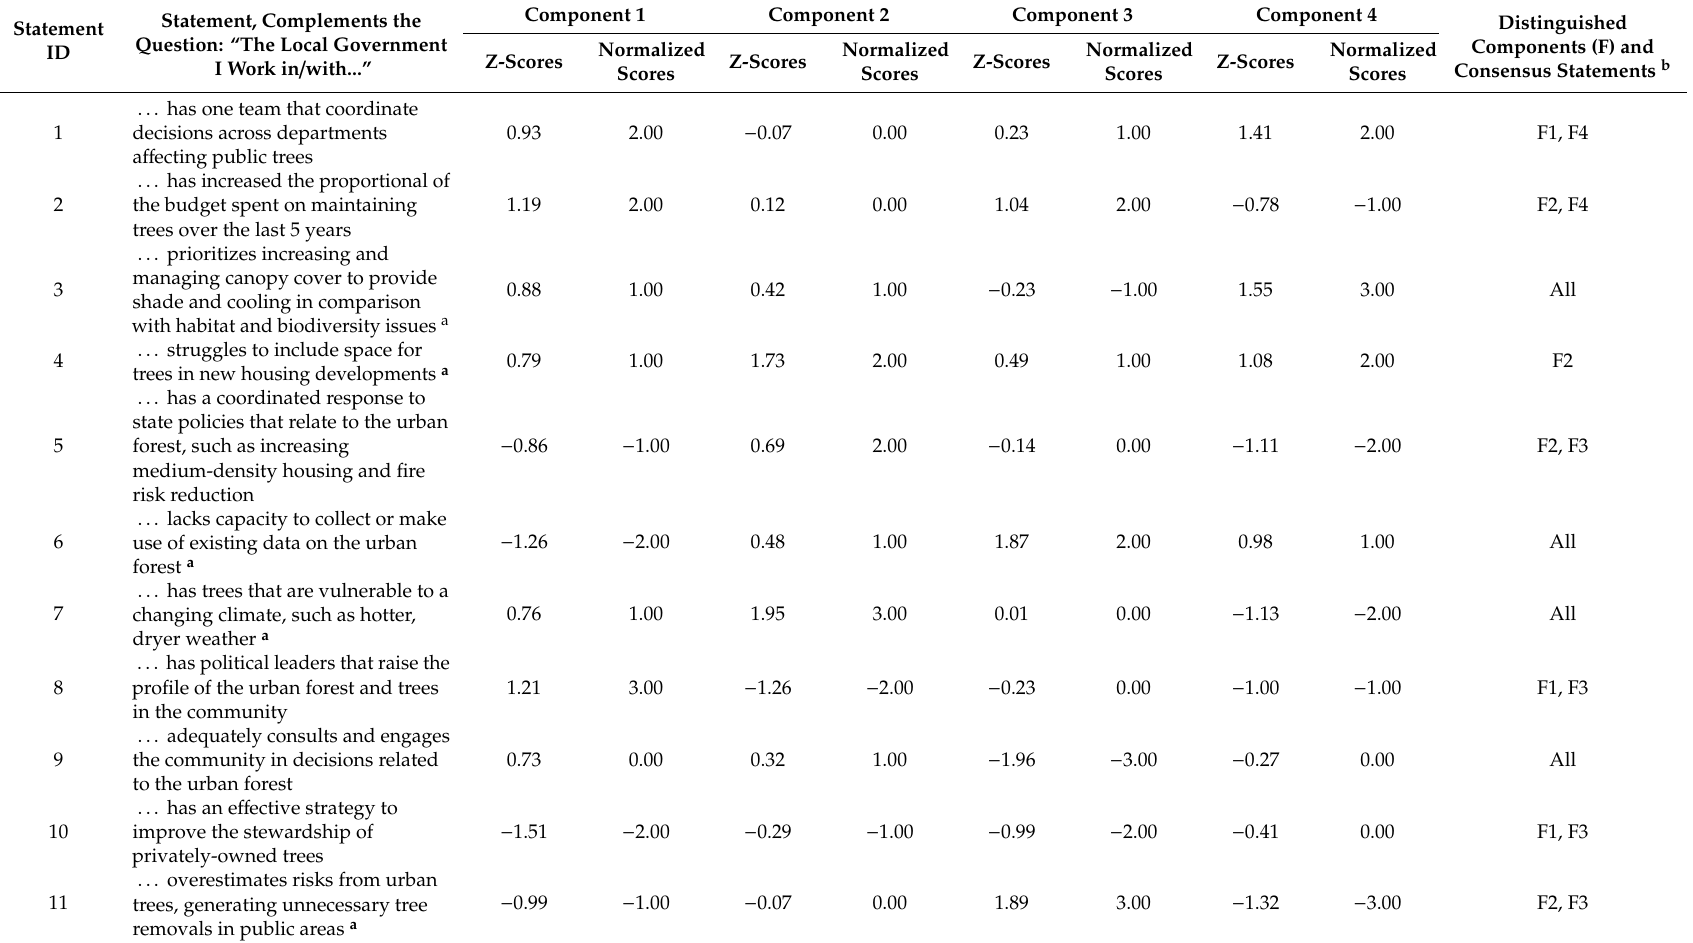
Table 2. Rotated component loadings, including z scores and normalized q scores, by